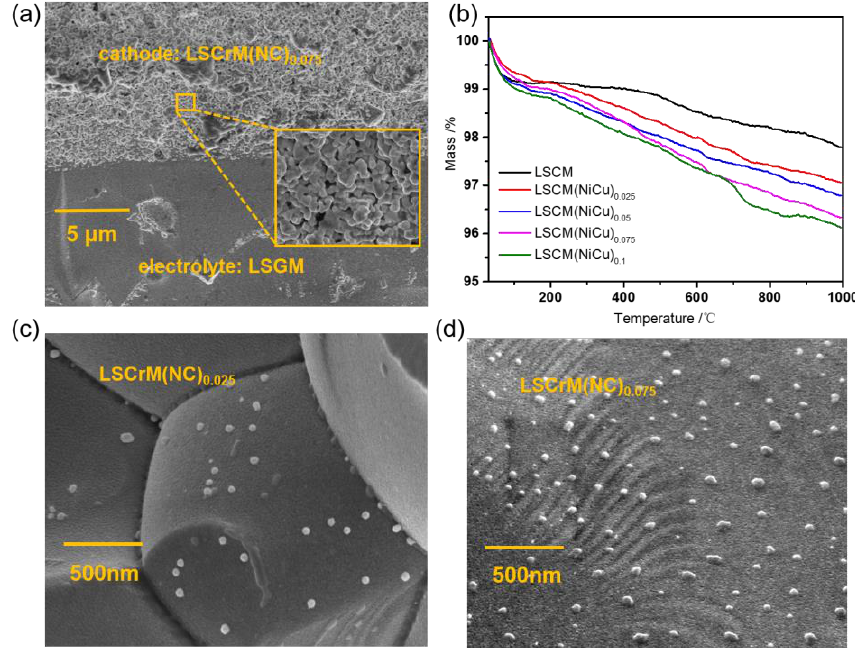
Figure 3. Microscopic morphology and thermogravimetry. ( a ) SEM images of cell cross−sections, ( b ) the TGA of LSCrM(NC) x at 5% H 2 /Ar, SEM of reduced ( c ) LSCrM(NC) 0.025 and ( d ) LSCrM(NC) 0.075 .